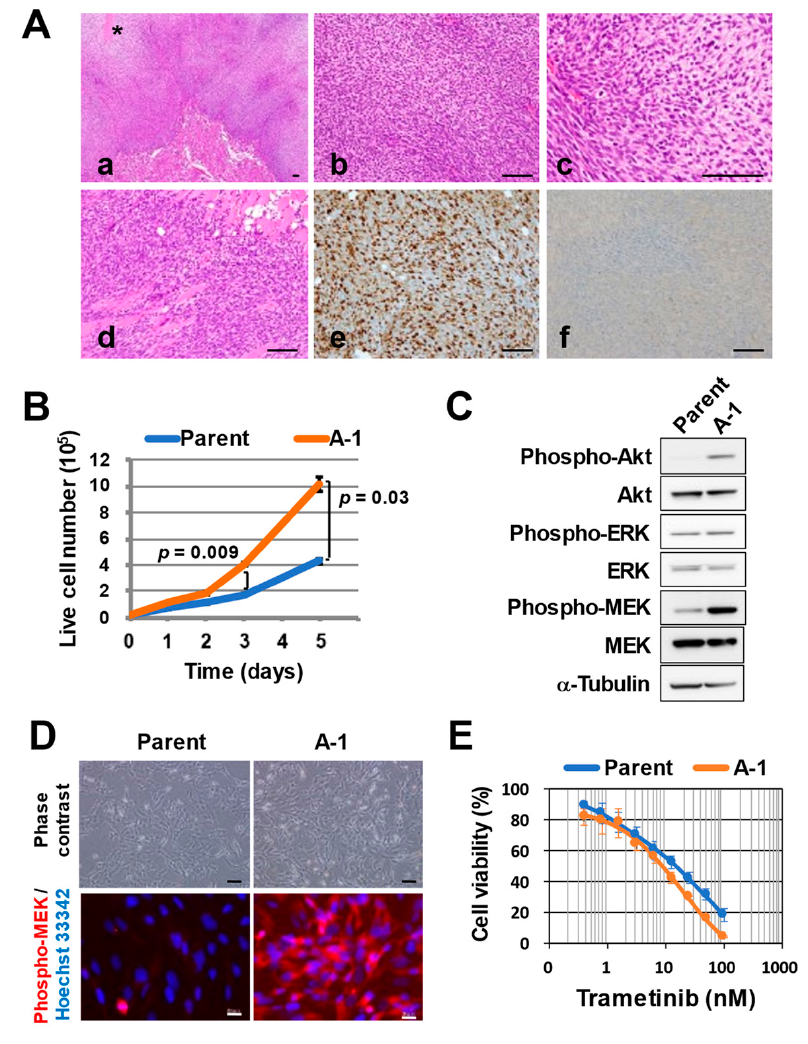
Figure 1. Establishment of tumor-derived cells via sNF96.2-GFP cell injection into a nude mouse. ( A ) Representative hematoxylin–eosin staining ( a – d ) and immunohistochemical staining of Ki67 ( e ) or S-100 ( f ) for a tumor formed at 154 days after kidney subcapsular injection of sNF96.2-GFP cells into a Balb/c nu/nu mouse. Scale bars, 100 µ m. Invasion of tumor cells into skeletal muscle is shown in image ( d ). The asterisk indicates a necrotic area. ( B ) Comparison of cell proliferative ability in vitro between sNF96.2-GFP (parent) and A-1 cells. Trypan-blue-negative cells were counted at the indicated times. Data are means ± SD from three independent experiments, and the p values were calculated with the two-tailed unpaired Student’s t test. ( C ) Immunoblot analysis of phosphorylated and total forms of Akt, ERK (extracellular signal-regulated kinase), and MEK (ERK kinase) in sNF96.2-GFP (parent) and A-1 cells. α -Tubulin was examined as a loading control. The uncropped western blot figures are shown in Figure S5. ( D ) Representative phase-contrast microscopy (scale bars, 100 µ m) and immunofluorescence staining of phospho-MEK (scale bars, 20 µ m) in sNF96.2-GFP (parent) and A-1 cells. Nuclei were stained with Hoechst 33342. ( E ) Comparison of the effects of trametinib on cell viability after incubation of sNF96.2-GFP (parent) or A-1 cells with the MEK inhibitor for 72 h. Data are means ± SD for four replicates of a representative